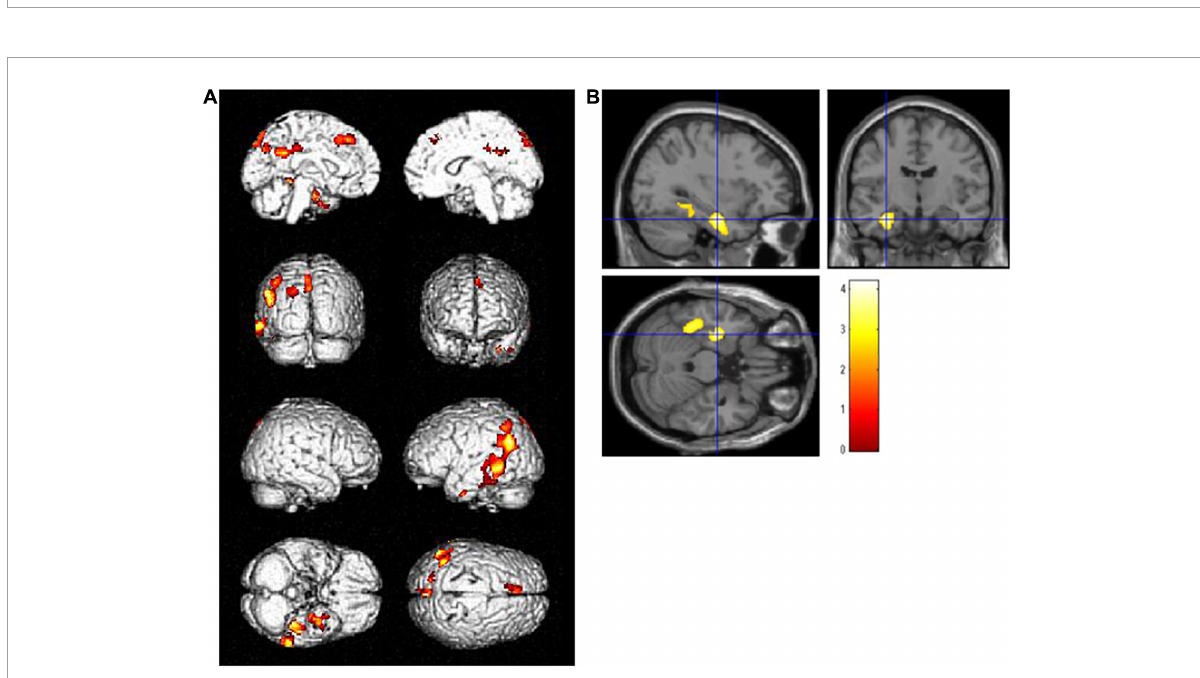
FIGURE2 Regions where regional glucose metabolism was inversely associated with years of school education upon controlling for the Alzheimer’s Disease Assessment Scale-Cognitive Component-Japanese version score in a combined group ( N = 57) of high- and low-education group. Statistically significant areas ( p < 0.01, extent threshold > 400) are displayed on (A) the brain surface projection and (B) multiplanar cross-sectional views. The red-yellow scale indicates the level of statistical significance. The blue crossed lines indicate the maximum peak voxel in the left hippocampus [(–32, –11, –24), T =